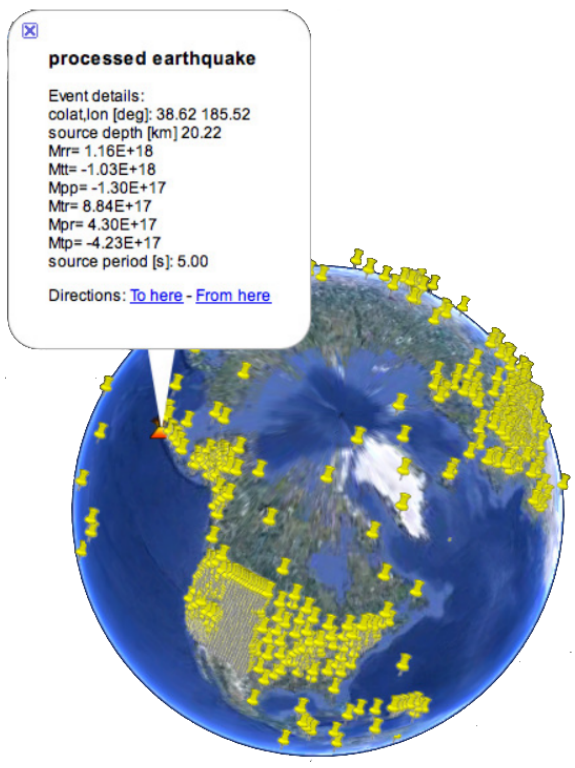
Figure 4. A Google Earth rendition of the source–receiver geom- etry used in an AxiSEM simulation. A generic output of the post- processing embedded within AxiSEM, this kml file contains earth- quake parameters (red dot) and actual seismogram images as links at the station locations (yellow pins).